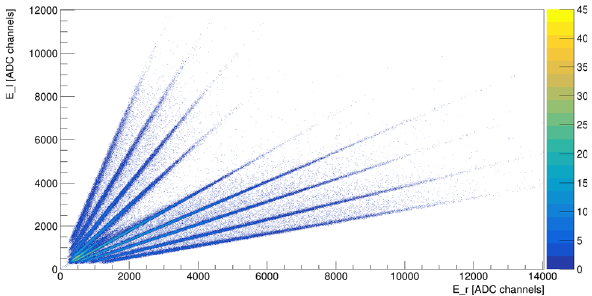
Fig. 26 Correlation spectrum obtained by the signals E r and E l mea- sured using 9 scintillator bars coupled to 9 SiPMs